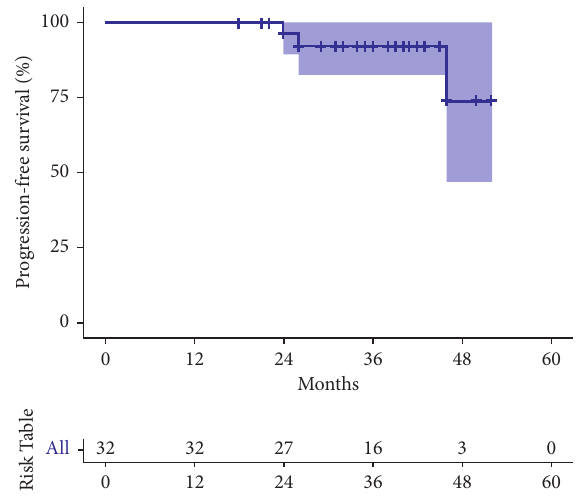
Figure 2: Kaplan–Meier analysis of progression-free survival Table 4: Infusion related reactions.